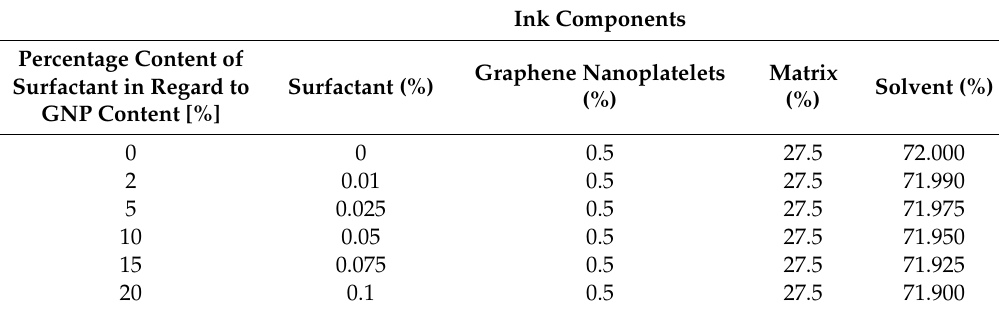
Table 3. Percentage content of ink